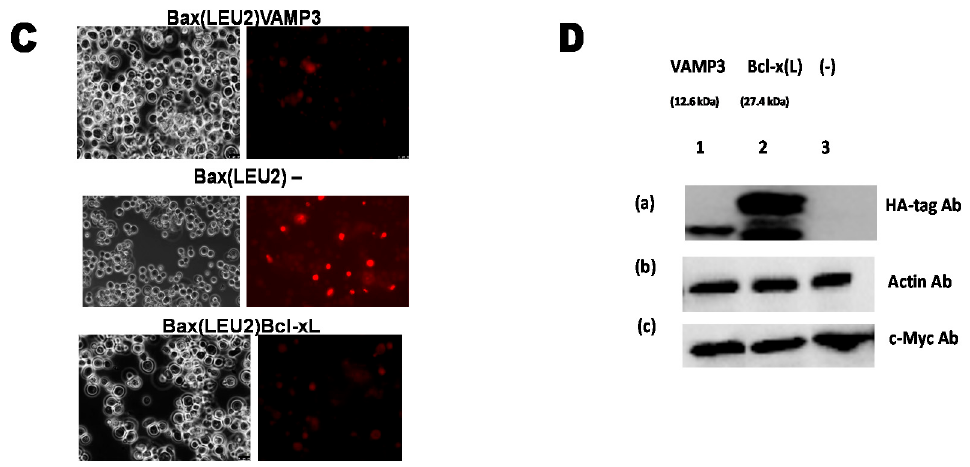
Figure 3. Reactive oxygen species (ROS) measurement, terminal deoxynucleotidyl transferase (TdT)-facilitated dUTP nick end labelling (TUNEL) assay, and Western blotting. ( A ) Measurement of ROS produced in the yeast strains Bax(LEU2) + VAMP3, Bax(LEU2) + Bcl xL, and Bax(LEU2) –. A two way ANOVA test shows that there was a signif- icant difference ( p < 0.05) between the control strain and each of Bax + VAMP3 and Bax + Bcl-xL, but there was no significant difference ( p > 0.05) between Bax + VAMP3 and Bax + Bcl-xL. The data represent the mean ± S.D. of three independent ex- periments. ( B ) TUNEL assay comparing the nuclear DNA fragmentations in yeast strains Bax(LEU2)VAMP3, Bax(LEU2)Bcl xL, and Bax(LEU2). The cells Bax(LEU2)VAMP3 and Bax(LEU2)Bcl xL have lower nuclear DNA fragmentation compared to Bax(LEU2)–cells. A two way ANOVA test shows that there was a significant difference ( p < 0.05) between the control strain and each of Bax + VAMP3 and Bax + Bcl-xL, but there was no significant difference ( p > 0.05) between Bax + VAMP3 and Bax + Bcl-xL. The data represent the mean ± S.D. of three independent experiments. ( C ) Represent the microscopic image of cells after tunnel assay, Bax(LEU2)VAMP3 and Bax(LEU2)Bcl xL. The left images are representative of cells under fluorescent light, showing dead cells (red) (high nuclear fragmentation) . ( D ) Western blot to monitor the presence of Bax in yeast cells that express only Bax and in cells that coexpress Bax together with VAMP3 and, Bcl-xL. Of total cellular proteins, in cell lysates, 10 µ g were loaded on to each lane and the blot was probed with an antibody that recognises the c-Myc-tag, Actin, and HA-tag. RFLU—Relative Fluorescence